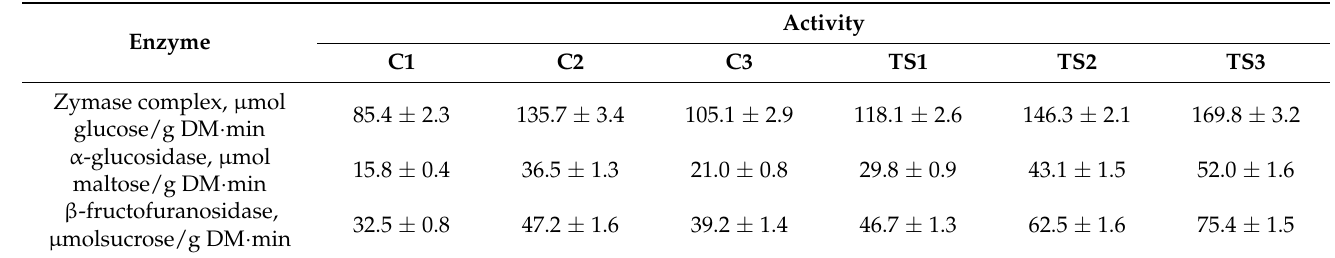
Table 2. Effect of combined treatment of yeast with ultrasound and a mix of Krebs cycle acids on the activity of individual